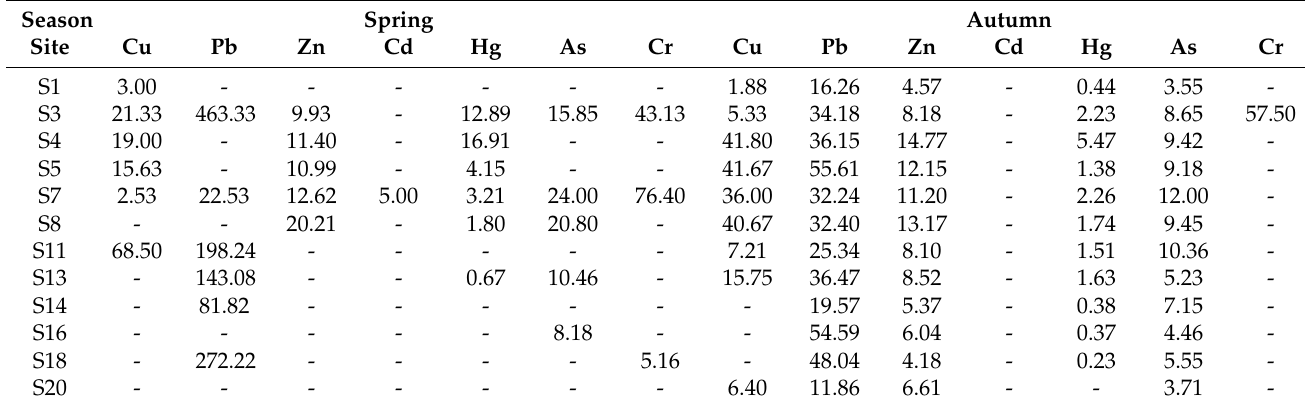
Table 2. Flowability of heavy metals in coastal